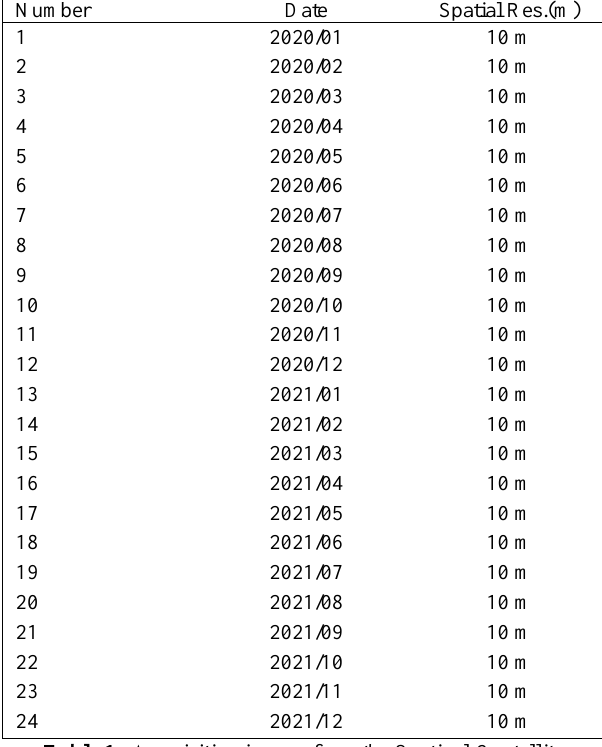
Table 1. Acquisition images from the Sentinel-2 satellite.